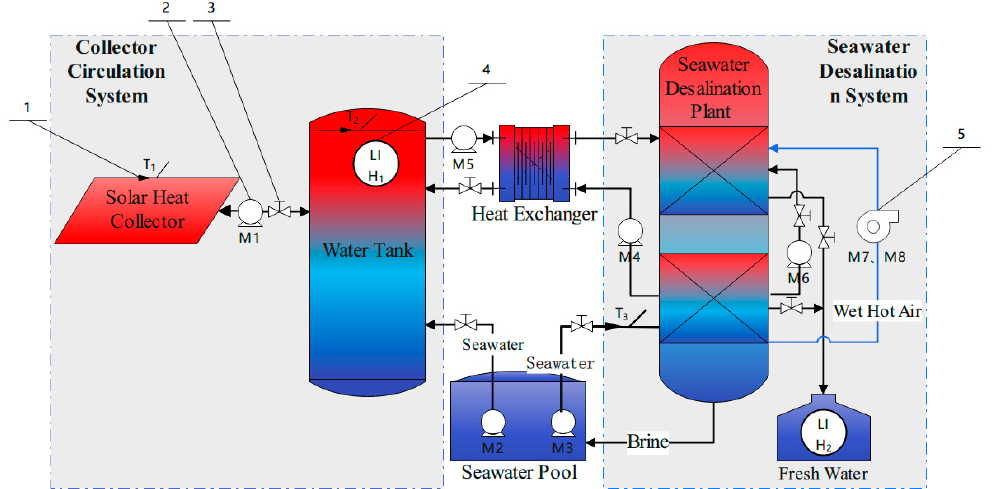
Figure 4. System block diagram of the desalination device and the heat collection cycle device: 1. Temperature Sensor; 2. Water pump; 3. Water valve; 4. Liquid level sensor; 5. Fans.